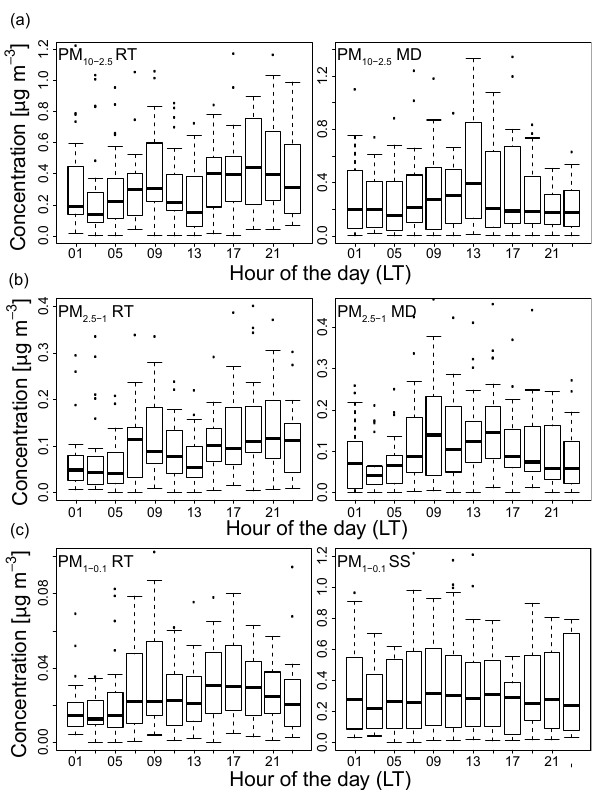
Fig. 12. Average Diurnal variations of the road traffic (RT), mineral dust (MD) and secondary sulfate (SS) factor: ( a ) shows the diurnal variations of the road traffic (RT) and the mineral dust (MD) factor for PM 10 − 2 . 5 , ( b ) shows the same for PM 2 . 5 − 1 . (c) shows the vari- ations of the road traffic (RT) and secondary sulfate (SS) factor for PM 1 − 0 . 1